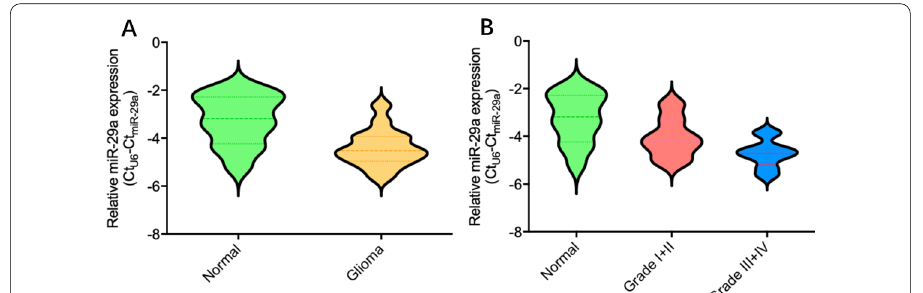
Fig. 1 Features of miR-29a expression in glioma samples and nontumoral brain tissues. A miR-29a expression was decreased in glioma samples as compared to nontumoral brain samples (P expression was decreased in glioma samples with high grade (III (P 0.0212) =